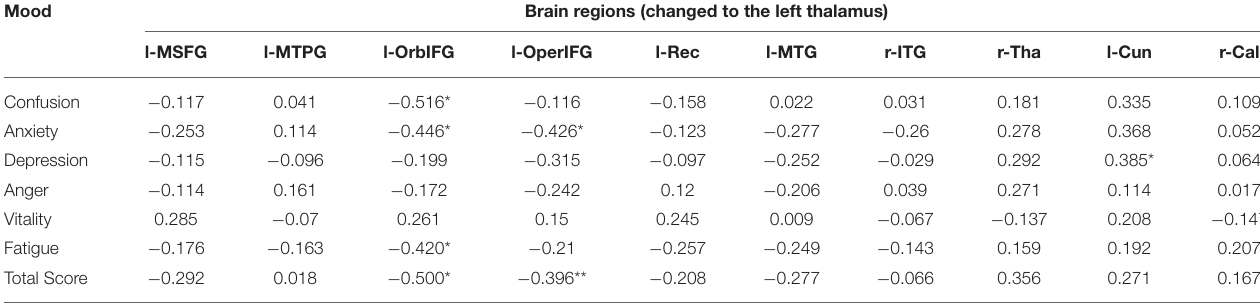
TABLE 3 | Correlation between changes in functional connectivity and changes in POMS ( n = 28). Mood Brain regions (changed to the left